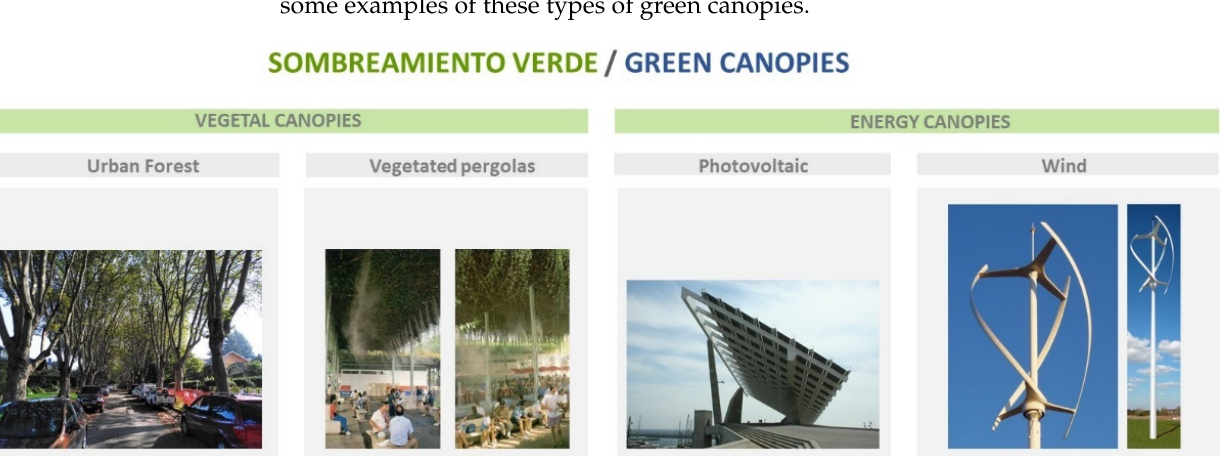
Figure A3. Types of green canopies (table and images by the authors, except images of vegetated pergolas [31] and wind turbines [63]).